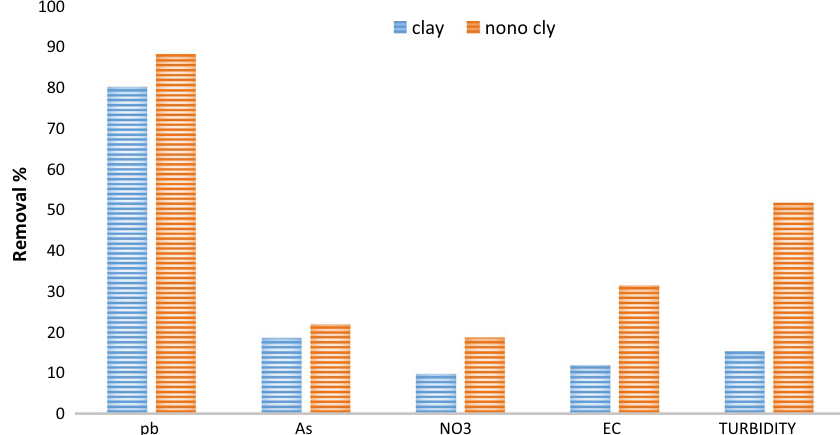
Fig. 3 Comparing the treatment efficiency of clay and